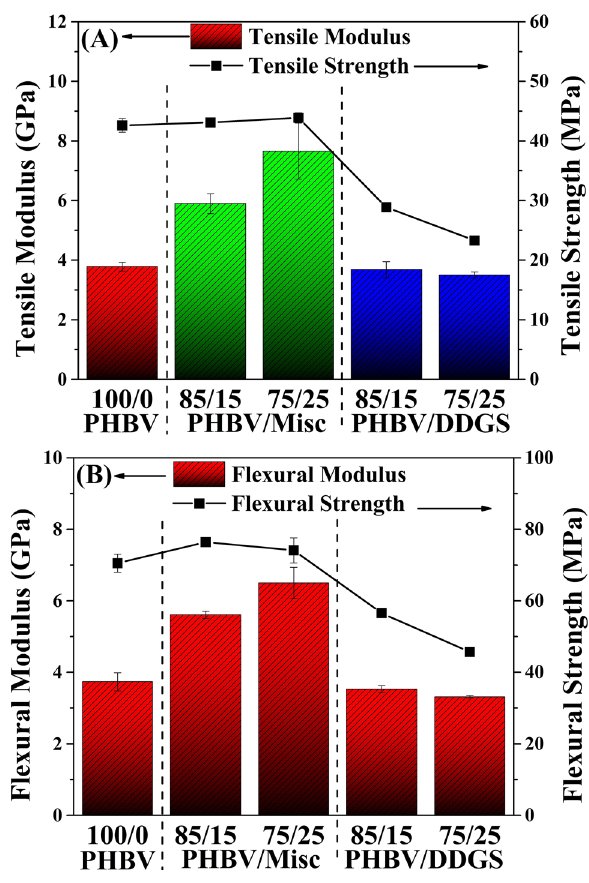
Figure 1. PHBV, PHBV/Misc and PHBV/DDGS. ( A ) Tensile modulus and strength, ( B ) flexural modulus and